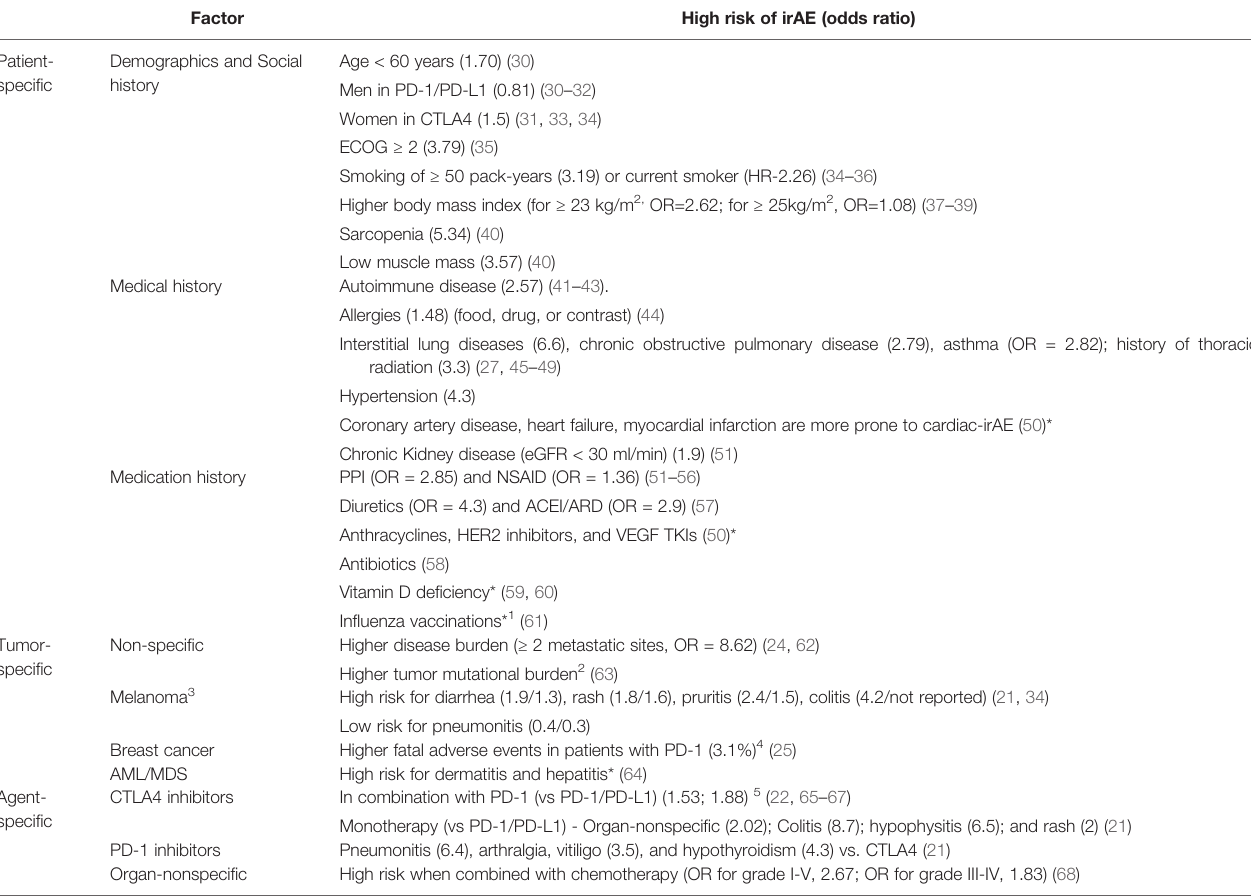
TABLE 1 | Risk factors and biomarkers for irAE